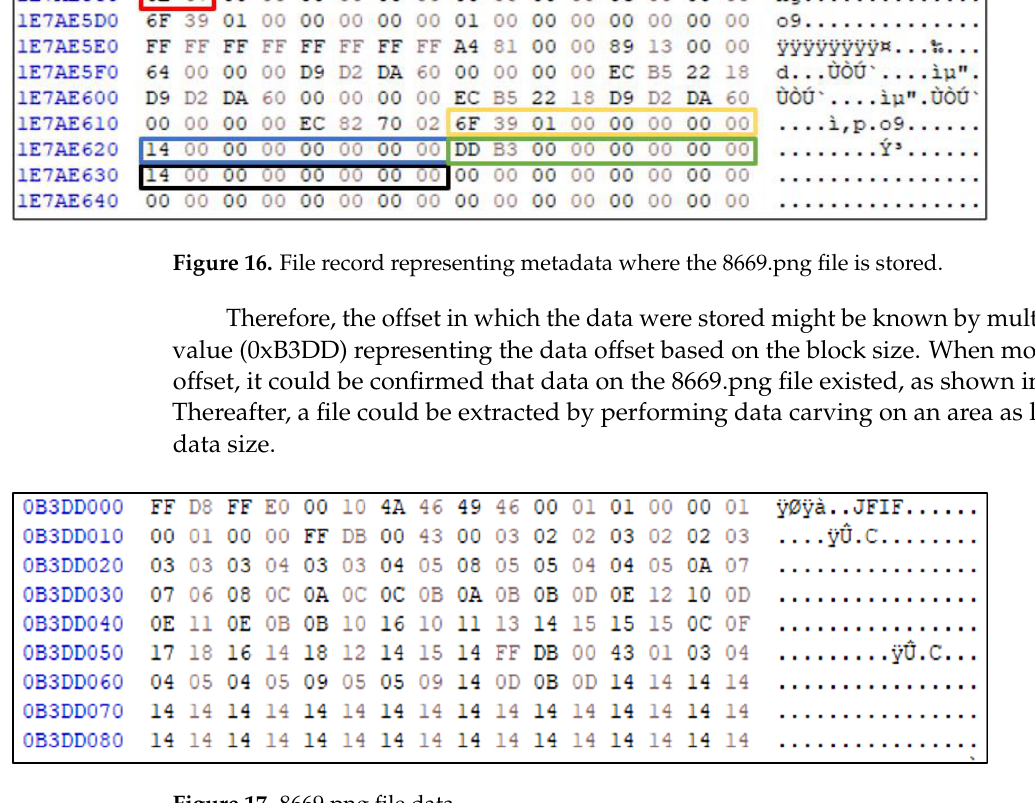
Figure 18. Dirent node ( top ) and inode ( bottom ) of ‘test3.txt’ file.